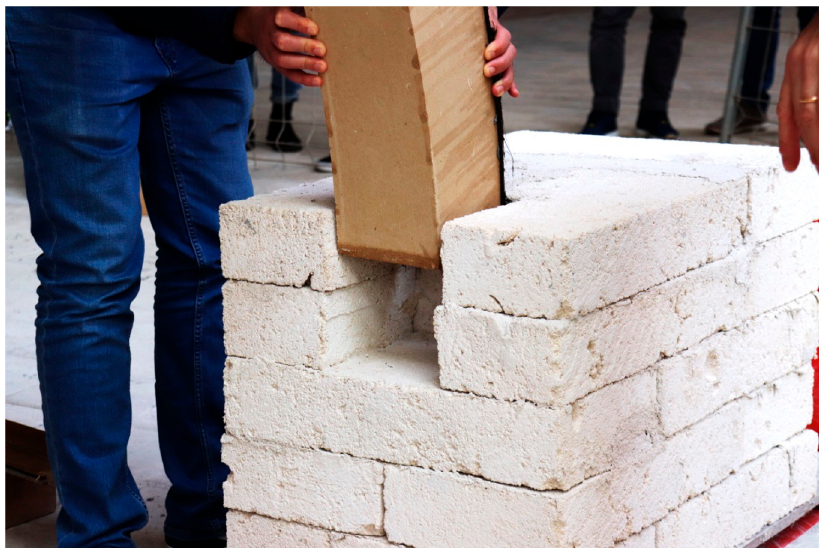
Figure A7. Positioning on the buttress.